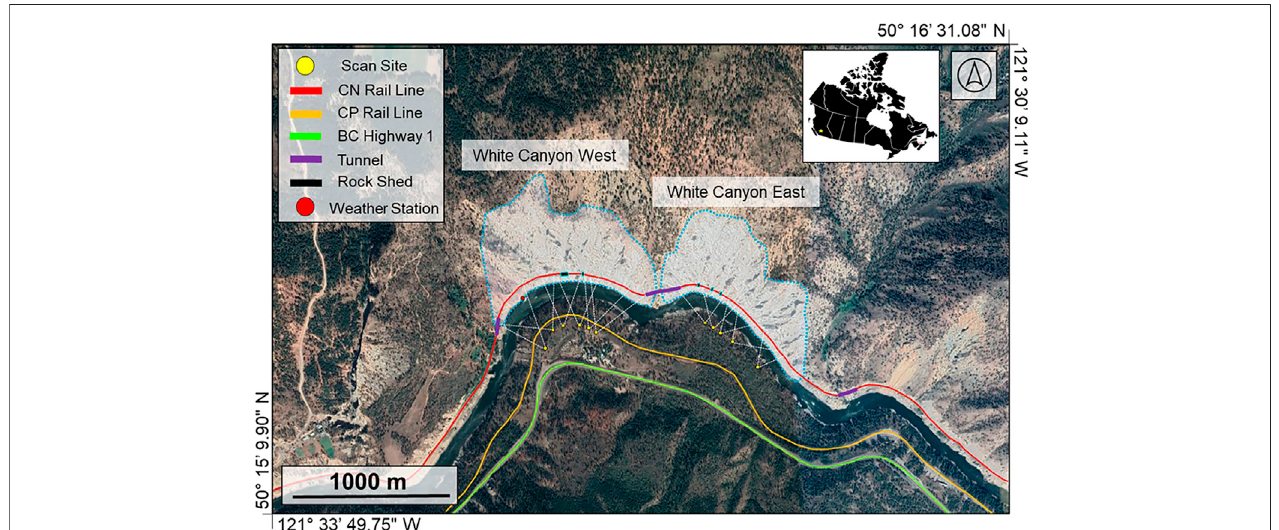
FIGURE 1 | Location of the study slope and TLS scanning positions. The scan extents and area are displayed in the light blue color for each site. The weather station corresponds to the White Canyon weather station.